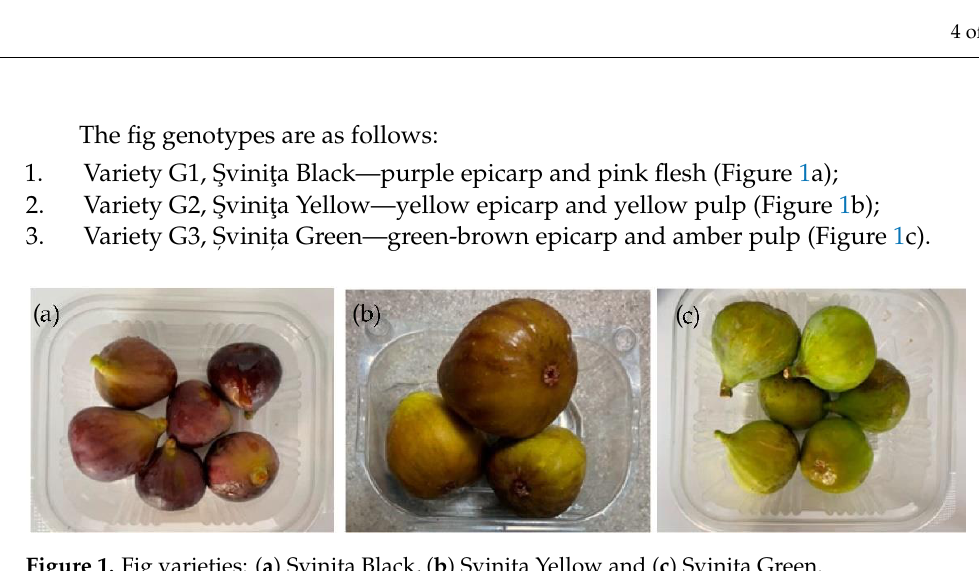
Table 1. Main physicochemical parameters for the figs used to produce fermented alcoholic beverages (values ± standard errors). Parameters *